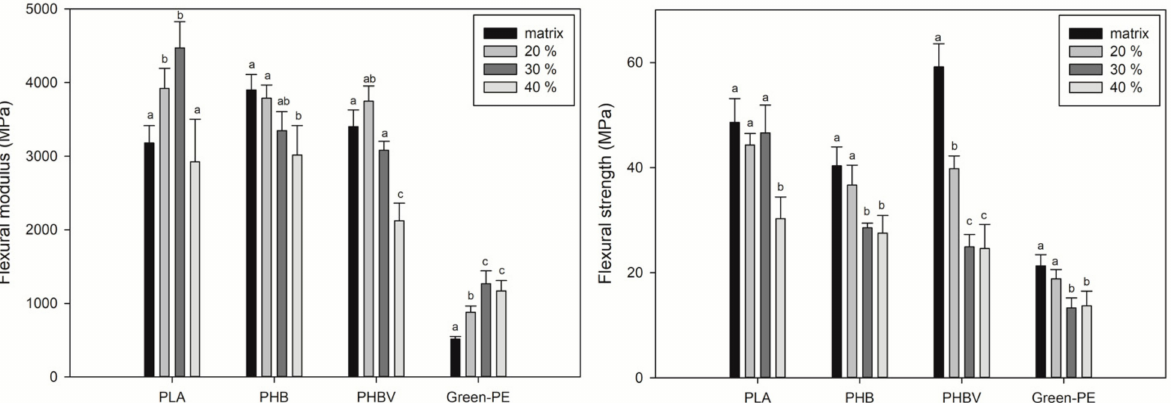
Figure 5. Flexural properties of the biocomposites. Different letters (a–c) on the bars indicate significant differences ( p <